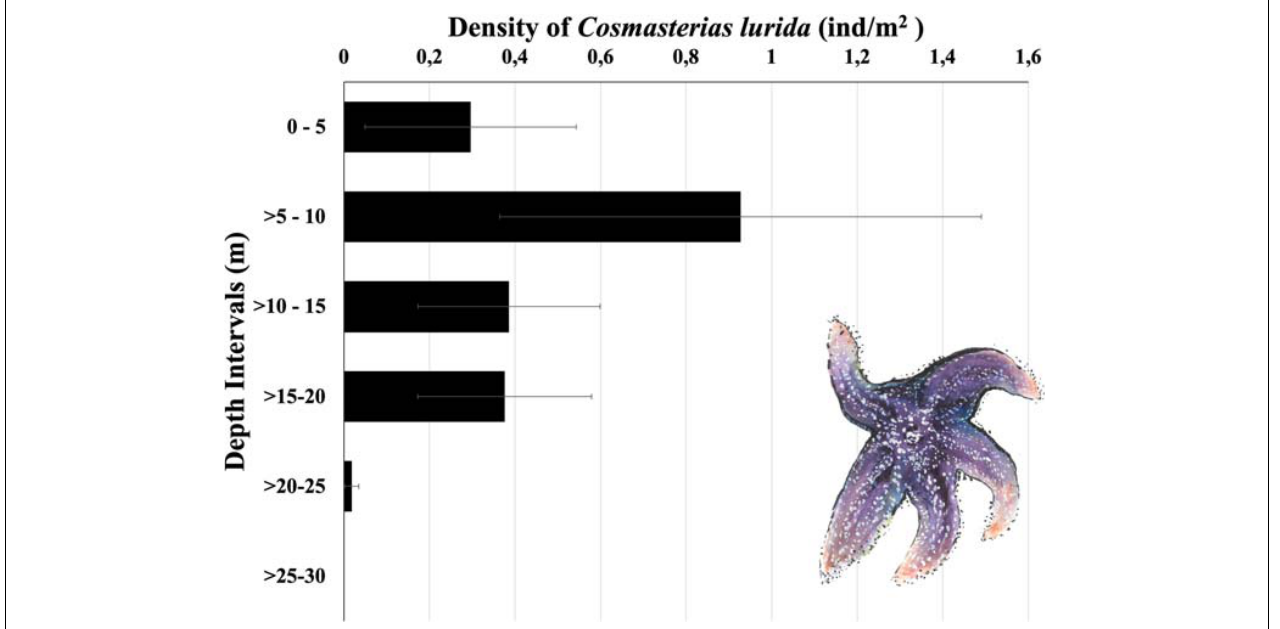
FIGURE 4 | Densities [mean (ind/m 2 ), SE] of the sea star Cosmasterias lurida at different depth intervals. The shallowest depth at which an individual was found 2.4 m (illustration of C. lurida by Fernanda